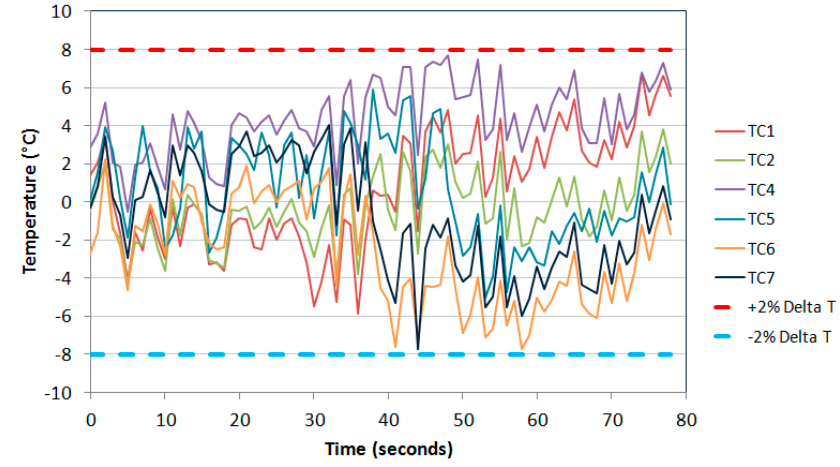
Figure 5. Thermocouple deviation over the 80-s thermal cycle.